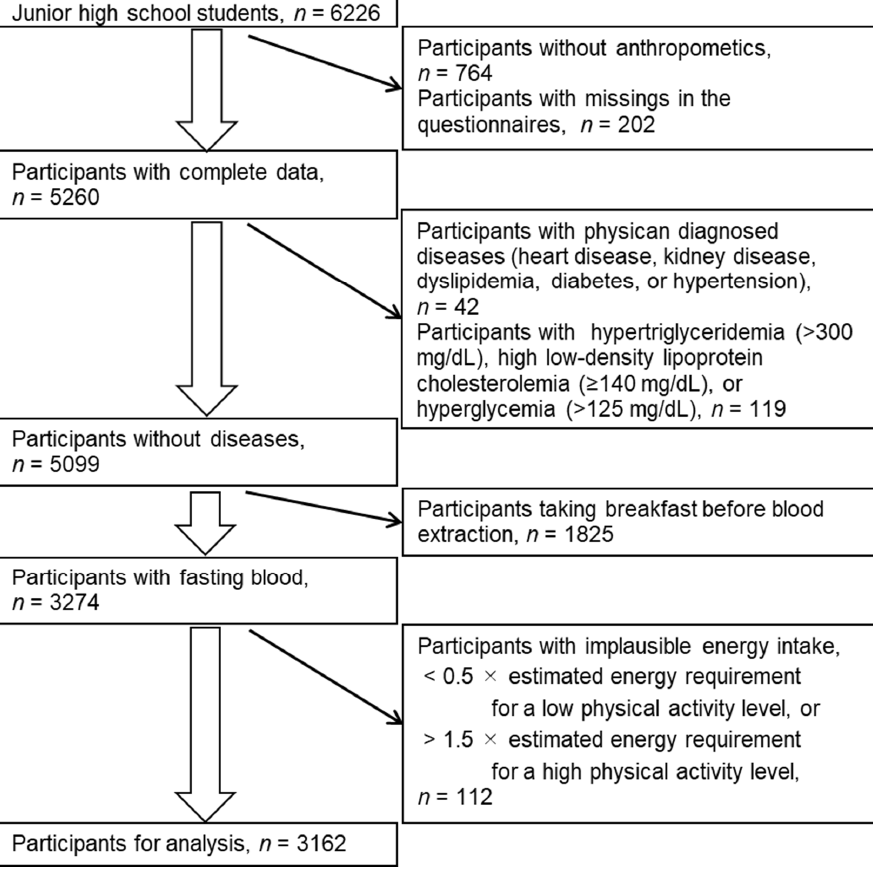
Figure 1. Selection of participants for analysis.